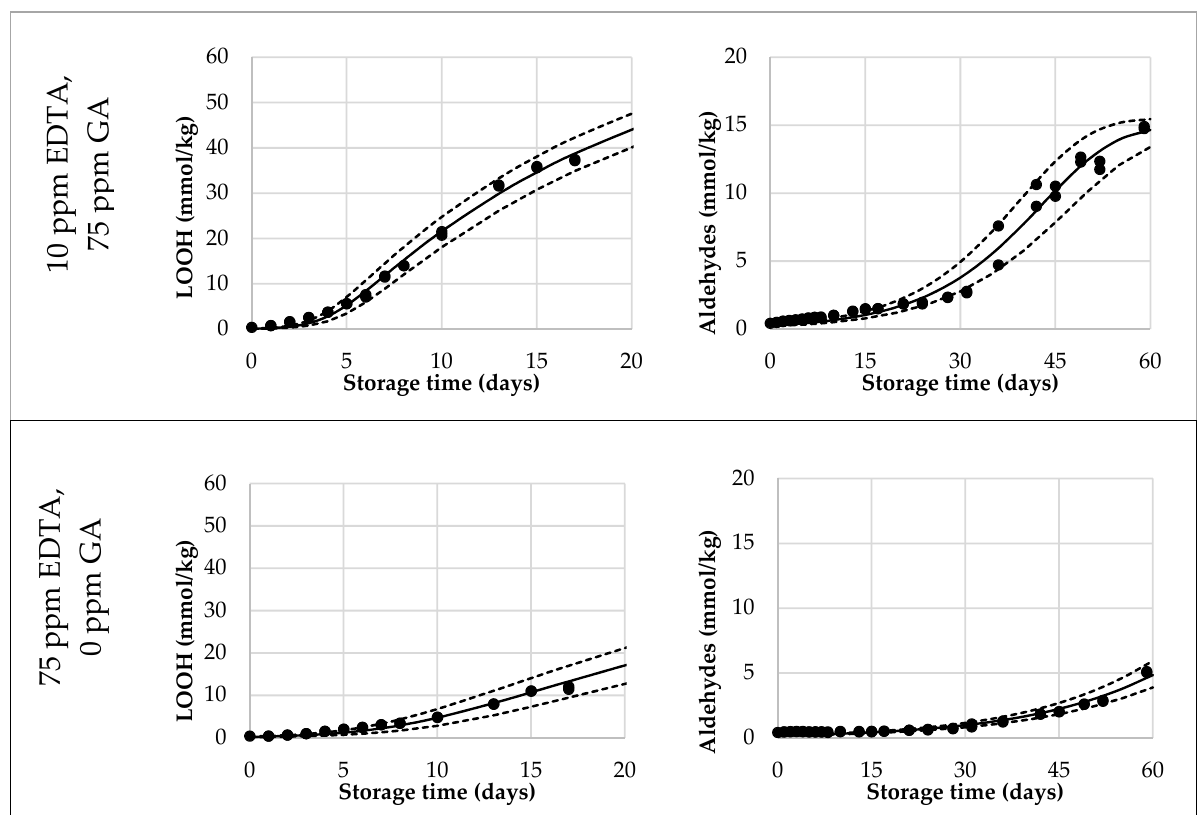
Figure 3. Selection of reduced Foubert (F3) regression results. The dots are the measured data points by 1 H NMR, the solid line corresponds to the F3 function, and the dashed lines represent the 95% confidence interval (CI). The left graphs represent the LOOH-data up to 40 mmol/kg, fitted with the F3 function with n = 16.7. The right graphs represent the aldehyde-data, fitted with the F3 function, with n = 1.1 to be used for the cross-point determination.